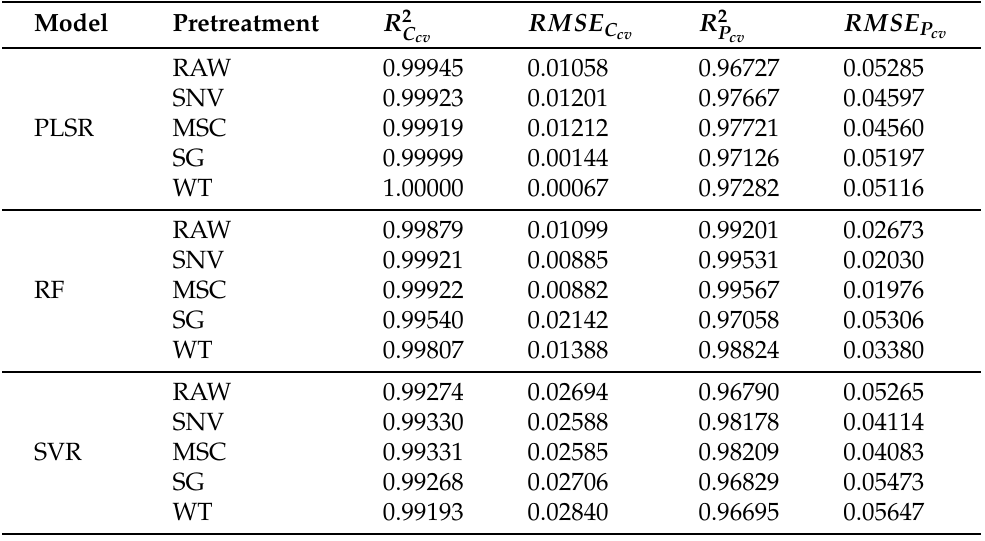
Table 2. Prediction results of sesame oil adulterated with soybean oil using full wavelengths.